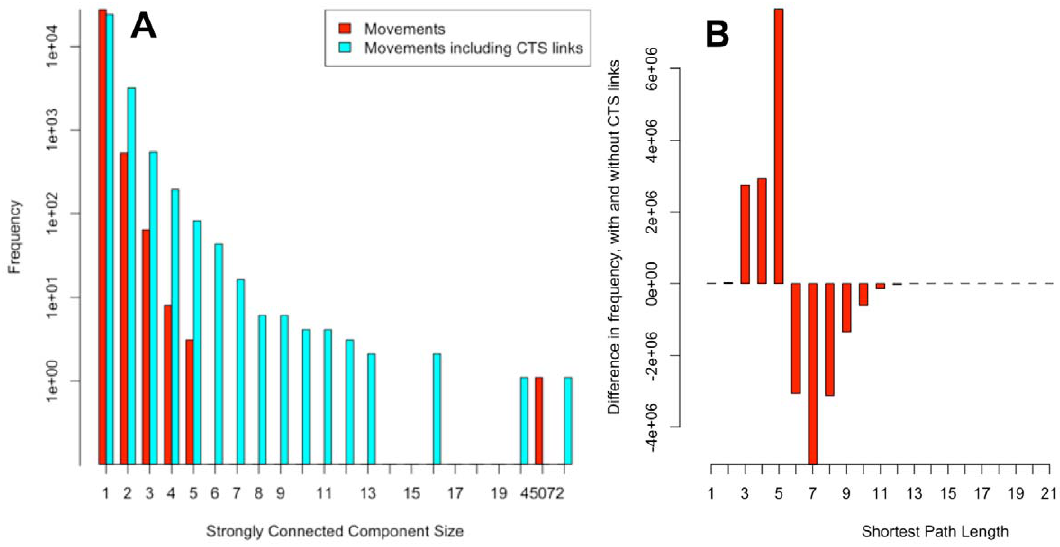
Figure 5. Shortest path analysis of cattle network with and without CTS Links. (A) Strongly connected component size of the cattle movements network for 2008 with (blue) and without (red) CTS Links. Adding CTS Links increases the size of the largest component (from 45072 to 54786, not shown here) and also increases the size and frequency of the smaller components; (B) Difference between the shortest path length distribution of connected premises in the cattle movements network for 2008 with and without CTS Links. The path length difference is calculated by subtracting the distribution of shortest path lengths for the movement network from the movement network with CTS Links (comparing the same connected premises).